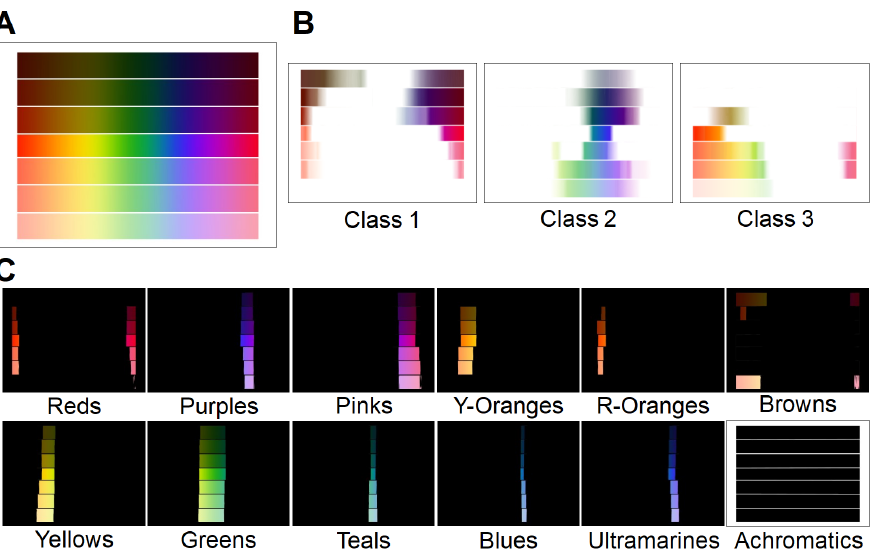
Figure 5. Comparison of segmentation with our method to fuzzy method in [41], using a simplified version of the image shown in Figure 1: ( A ) the middle rectangle shows the unraveled color wheel; the rectangles above (below) add an increasing quantity of black (gray) to represent shades (tones); ( B ) results of classification using fuzzy color spaces with three arbitrary classes; the lack of labels, and the gradual transitions between colors, resulted in membership maps with small areas of absolute membership, and unclear class separations; ( C ) results of color classification using ABANICCO; our method automatically divided the image into 12 classes with clear boundaries, corresponding to the main hues present plus the near-achromatic brown shades and tones and the achromatic white and black (empty for this particular